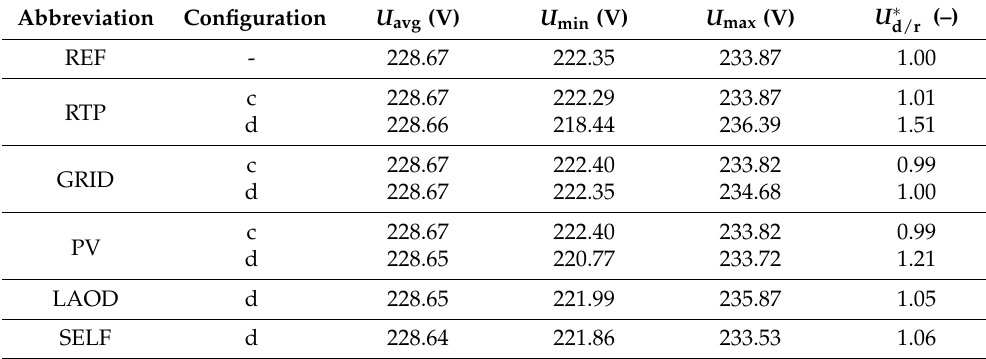
Table A2. Voltage results achieved for a single, central storage (c) and multiple, distributed storages (d) driven by different incentives. The superscript * refers to normed quantities with respect to the = U d/r reference case, i.e., U ∗ U d/r, REF d/r